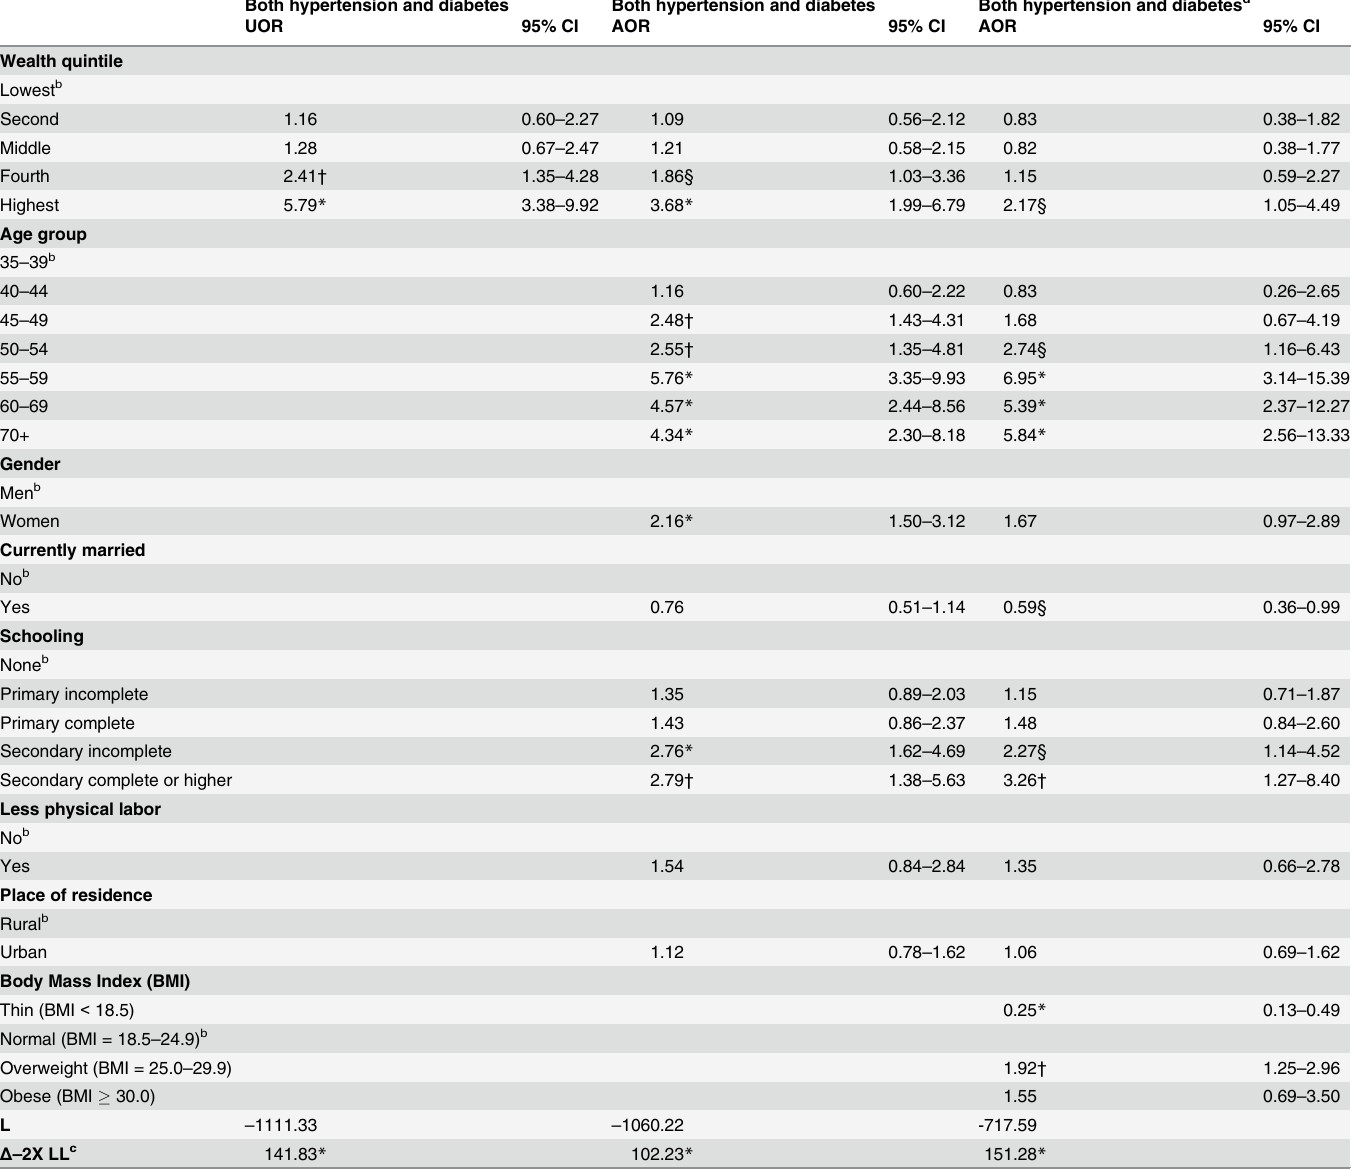
Table 4. Odds ratios of having versus not having morbidity in Bangladesh (N = 7499) a